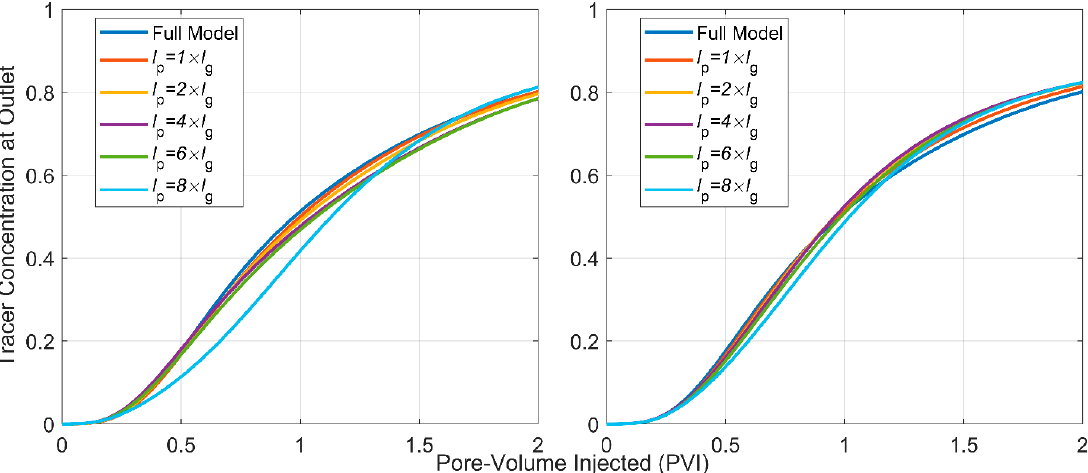
Figure 9. Tracer concentration at the outlet as a function of pore-volume injected for full model, Ups-CP, and Ups-LP for l p = l g ( left ) and l p = 8 × l g ( right ). Energies 2020 , 13 , x FOR PEER REVIEW